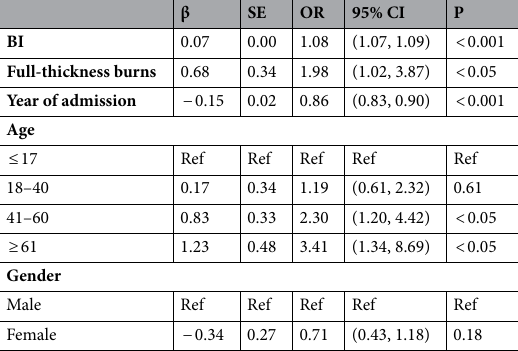
Table 6. Logistic regression of factors related to the mortality.